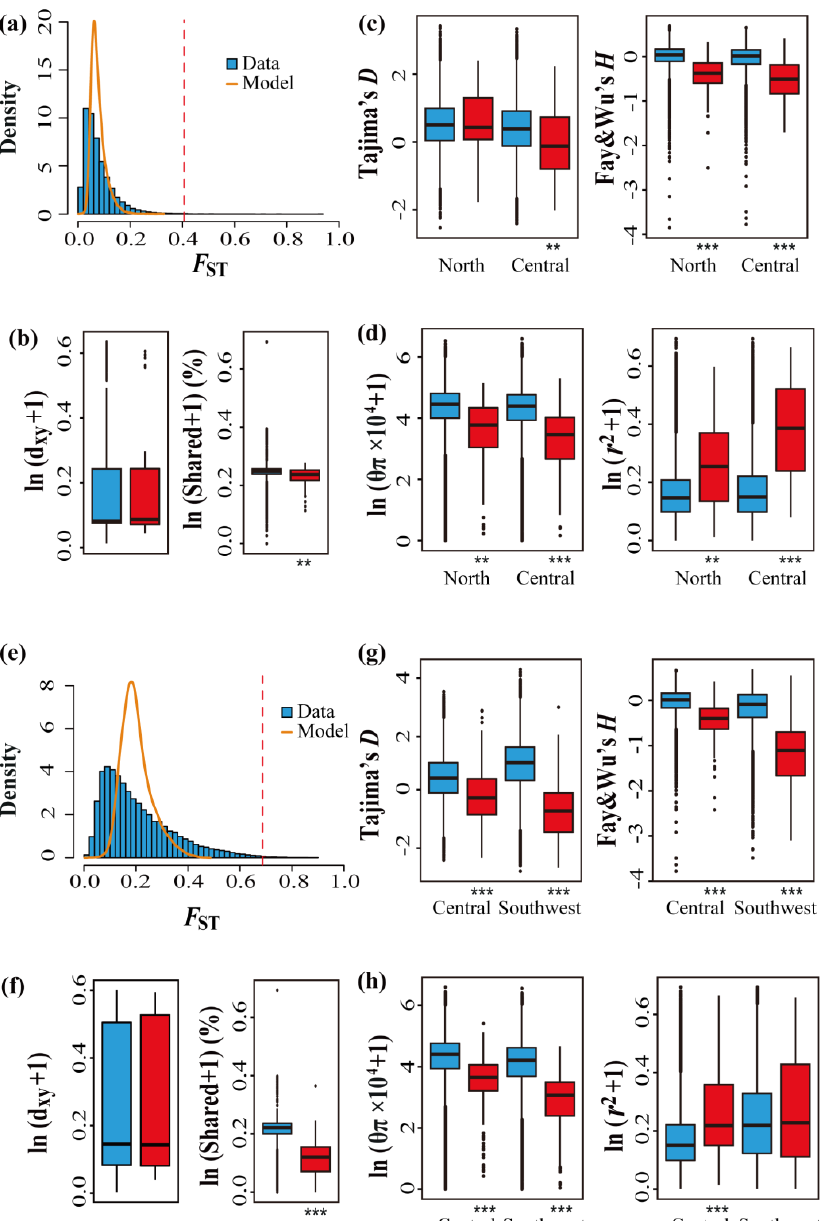
Figure 3. Identification of candidate outlier windows that may be affected by natural selection. ( a – d ) Genetic parameters between the north and central populations. ( e – h ) Genetic parameters between the central and southwest populations. ( a , e ) Distribution of genetic differentiation ( F ST ) between two populations from the observed (blue bar) and simulated datasets (orange line). The dotted line represents the thresholds for determining significantly (false discovery rate <5%) high (red bars) genetic differentiation based on coalescent simulations. ( b , f ) Comparisons of d xy (absolute measure of divergence) and the proportion of inter-population shared nucleotide diversity between regions with significantly high genetic differentiation (red boxes) and the genomic background (blue boxes). ( c , g ) Comparisons of Tajima’s D and Fay and Wu’s H between regions with significantly high genetic differentiation (red boxes) and the genomic background (blue boxes). ( d , h ) Comparisons of nucleotide diversity ( θ π ) and LD ( r 2 ) between regions with significantly high genetic differentiation (red boxes) and the genomic background (blue boxes). Asterisks indicate significant differences between high-genetic-differentiation and background genomic regions based on Mann–Whitney U tests (** p -value < 1 × 10 − 4 ; *** p -value < 2.2 × 10 − 16